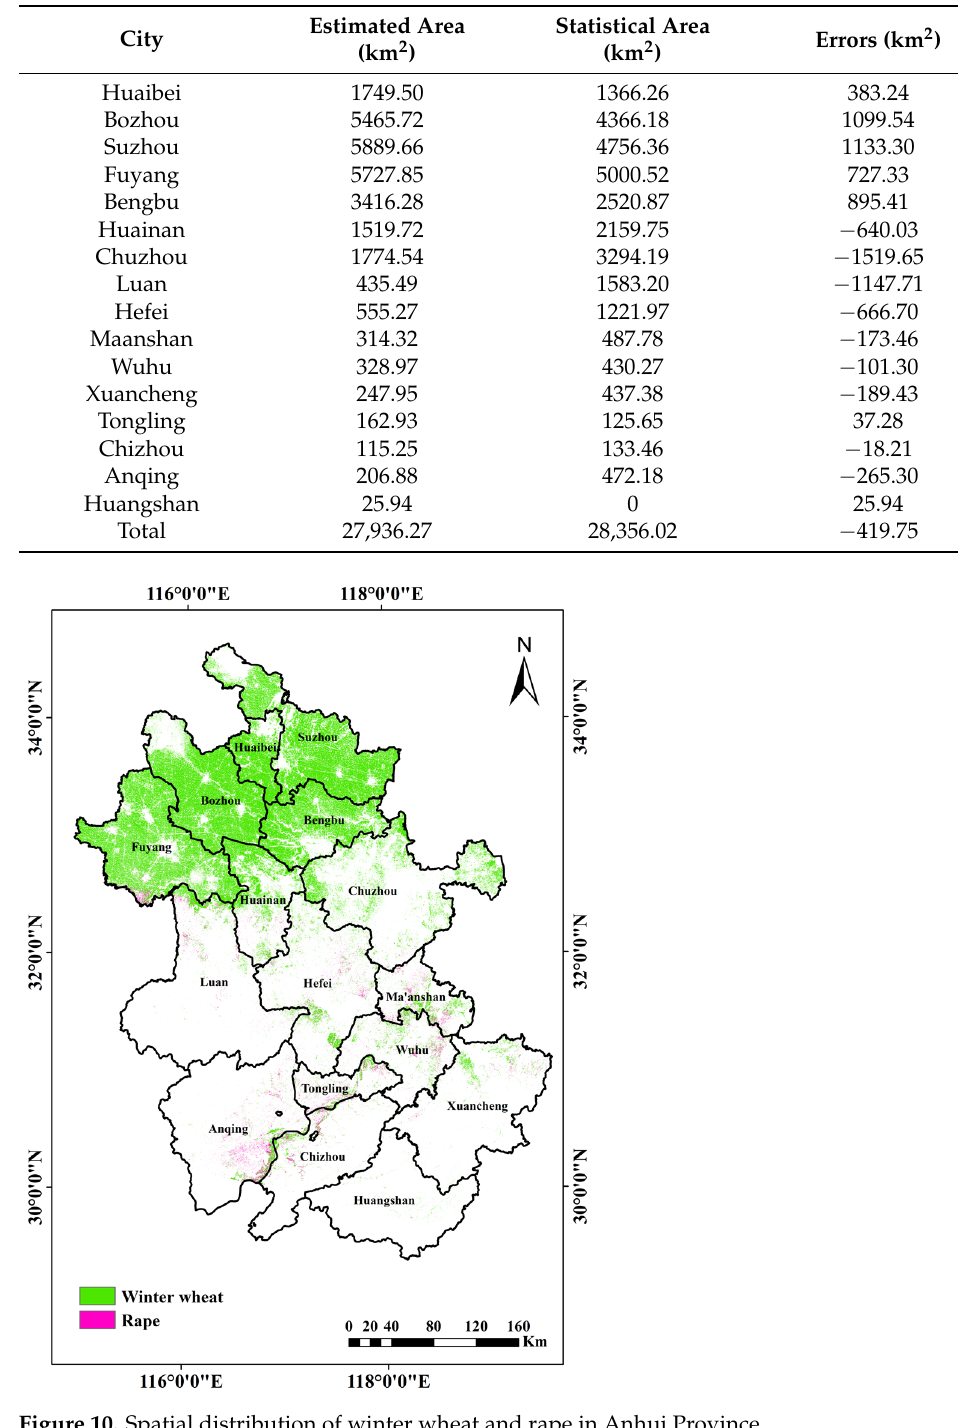
Table 7. Comparison of winter wheat planting area.